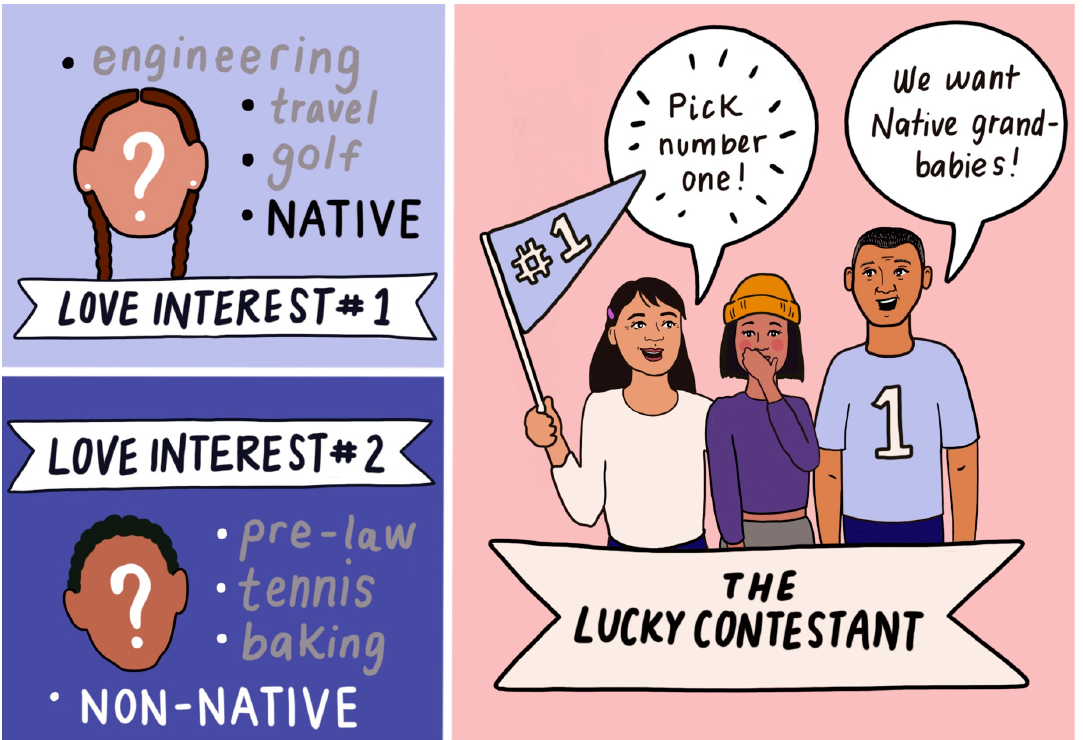
Figure 10. This panel shows two options of individuals to date, as if partner choice was a game